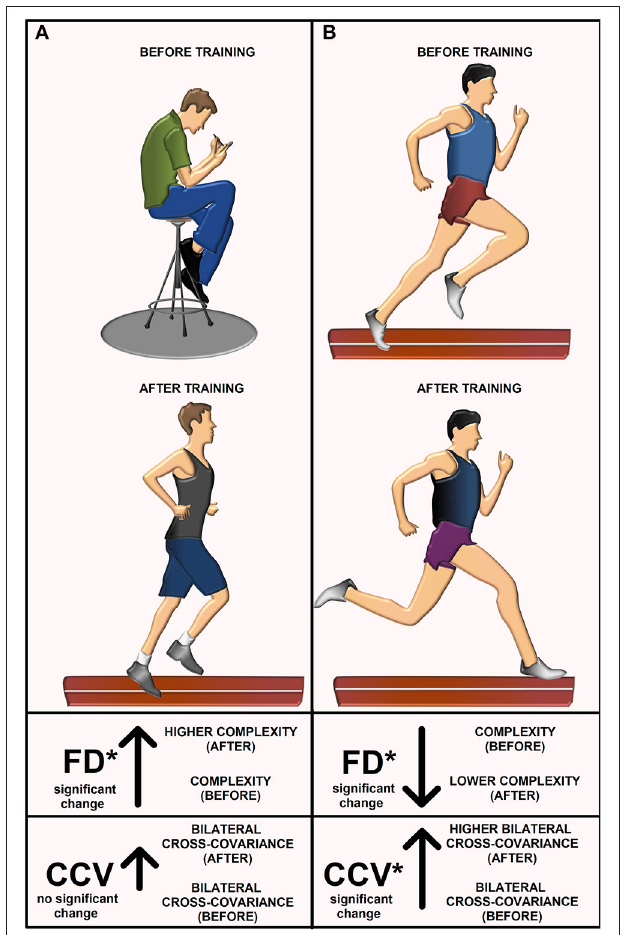
FIGURE 6 | The cartoon explains the main results. Illustration before and after training for (A) sedentary individuals and (B) athletes. The FD for sedentary individuals increased after track training. They exhibited a non-significant increase in the cross-covariance CCV between left and right H-wave fluctuations. The FD for athletes decreased and the CCV